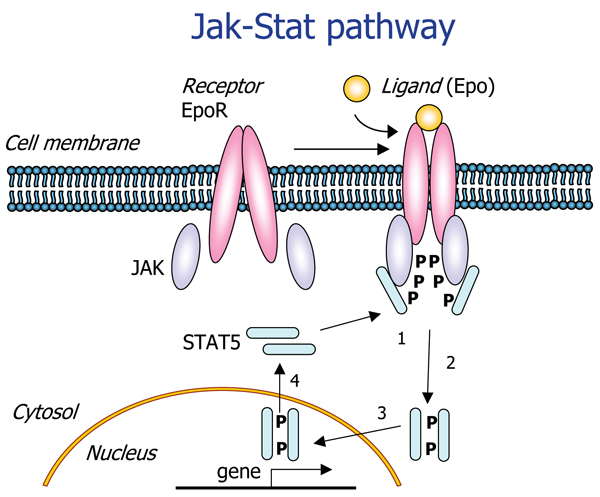
Jak-Stat Pathways. Jak-Stat pathways entail the receptor Janus kinase (Jak) and the signal transducer and activator of transcription (Stat). Stat molecules are inactive as monomers, and their activation involves phosphorylation and dimerization. The binding of the ligand (here the hormone Epo) to the receptor (EpoR) results in phosphorylation of Jak and of the cytoplasmatic domain of EpoR. Monomeric Stat5 is recruited to the phosphorylated and thereby activated receptor, EpoRA. (1) Upon receptor recruitment, monomeric Stat5 is tyrosine-phosphorylated. It dimerizes (2) and migrates to the nucleus (3), where it binds to the promoter of target genes. After dissociation (4), it is dephosphorylated and exported to the cytoplasm.